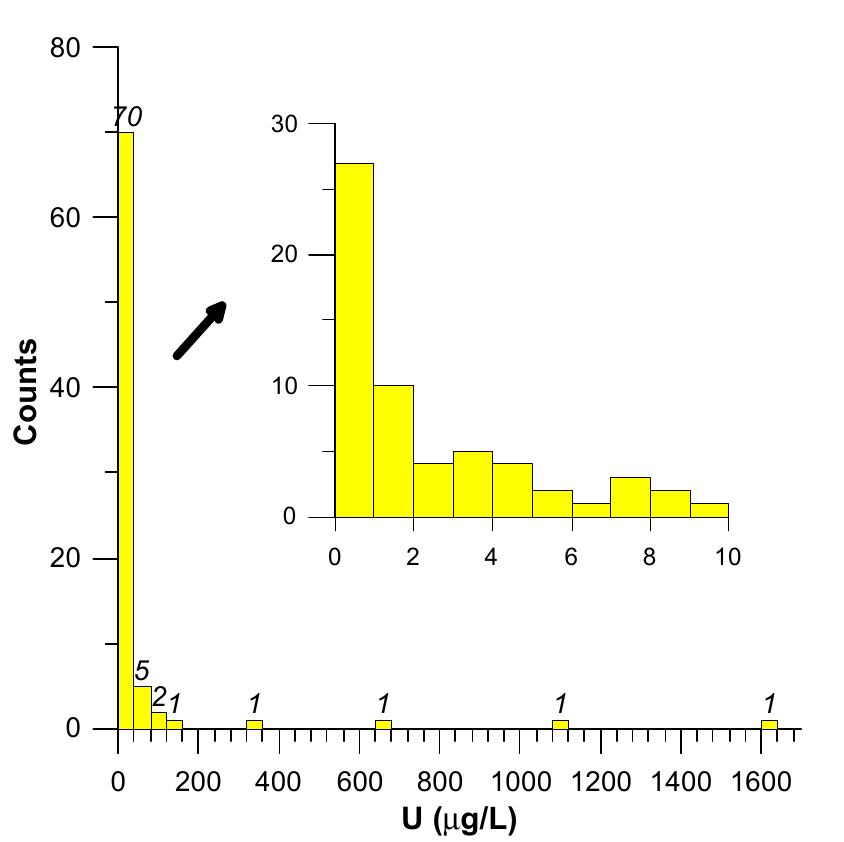
Figure 2. Histograms showing the distributions of a wide range of uranium concentrations in groundwater. The inset diagram (right) designed for low levels below 10 μ g/L indicates that most samples have very low in uranium concentrations. Italic values on the top of bars denote sample numbers. The width of each bar at the bottom graph corresponds to 40 μ g/L range.